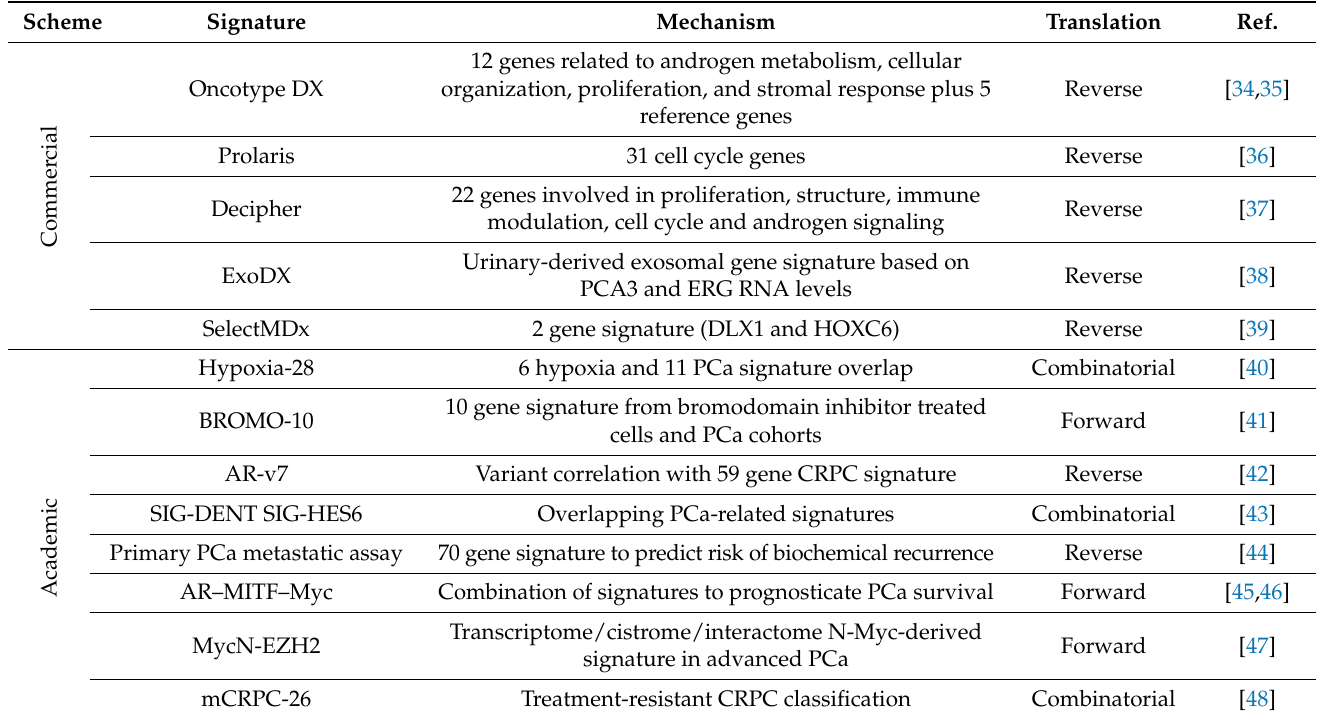
Table 1. Signatures involving TF biology in PCa. There have been significant advances in molecularly subtyping PCa with a few diagnostic and prognostic tests available [33]. However, the widespread clinical utility of such tests in PCa is still being reviewed, with the complex underlying biology and disease heterogeneity posing significant barriers to a population-wide utilization. Moreover, most commercially available signatures were the products of reverse translation and clinical profiling. This is because the application of these signatures is in an incredibly complex setting (the clinic), and so far, there have not been sufficiently powerful pre-clinical models to overcome issues such as heterogeneity. This is increasingly being addressed by the emergence of patient-derived explants and organoids, which offer a significantly improved translational model of PCa compared to cell lines. As this table demonstrates, there is a drive in pre-clinical research to combine signatures to determine the effect of multiple key molecular pathways on disease evolution. This is a space that most commercially available signatures are currently not occupying as they focus on singular TFs (androgen receptor; AR) or single